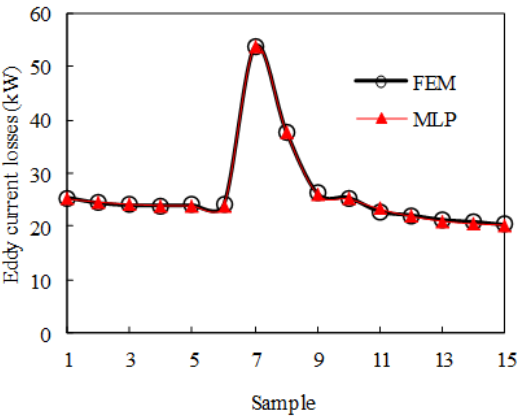
Figure 13. Learning results based on MLP. Table 4. Predicted eddy current losses of the test sample set